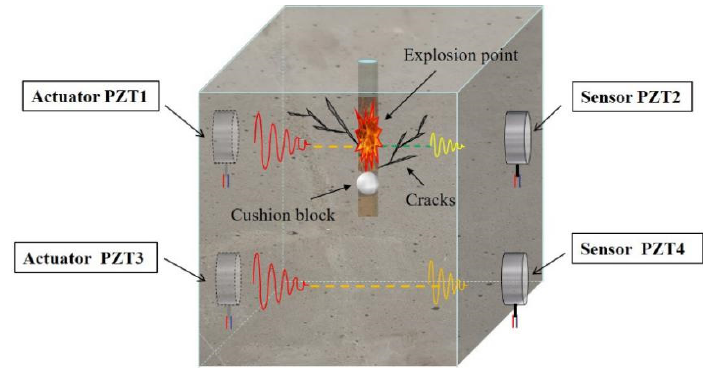
Figure 3. Lead zirconate titanate (PZT)-based active sensing to detect concrete damage.